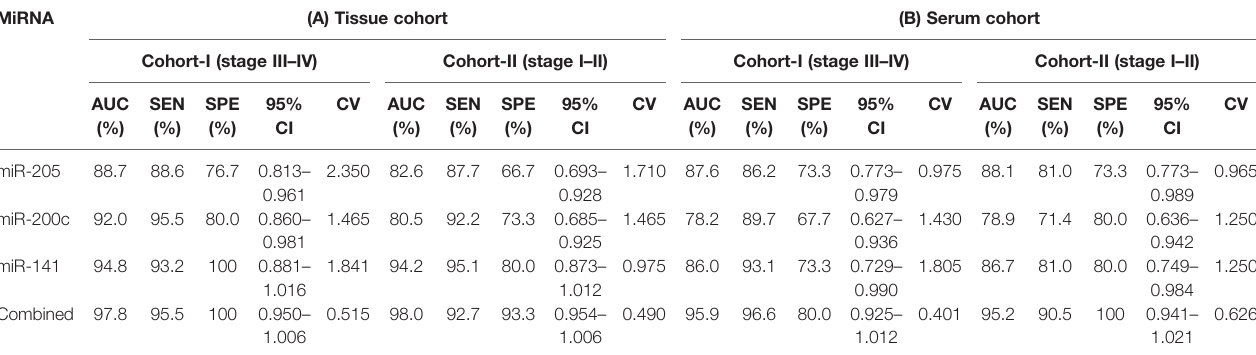
(A) Evaluation of diagnostic performance of each miRNA in tissue cohort-I and cohort-II. (B) Evaluation of diagnostic performance of each miRNA and combined miRNA panel in serum cohort-I and cohort-II. AUC, area under the curve; SEN, sensitivity; SEP, speci fi city; CI, con fi dence interval; CV, optimum cut-off values; Combined, cumulative predicted probability of miR-205+ miR-200c +